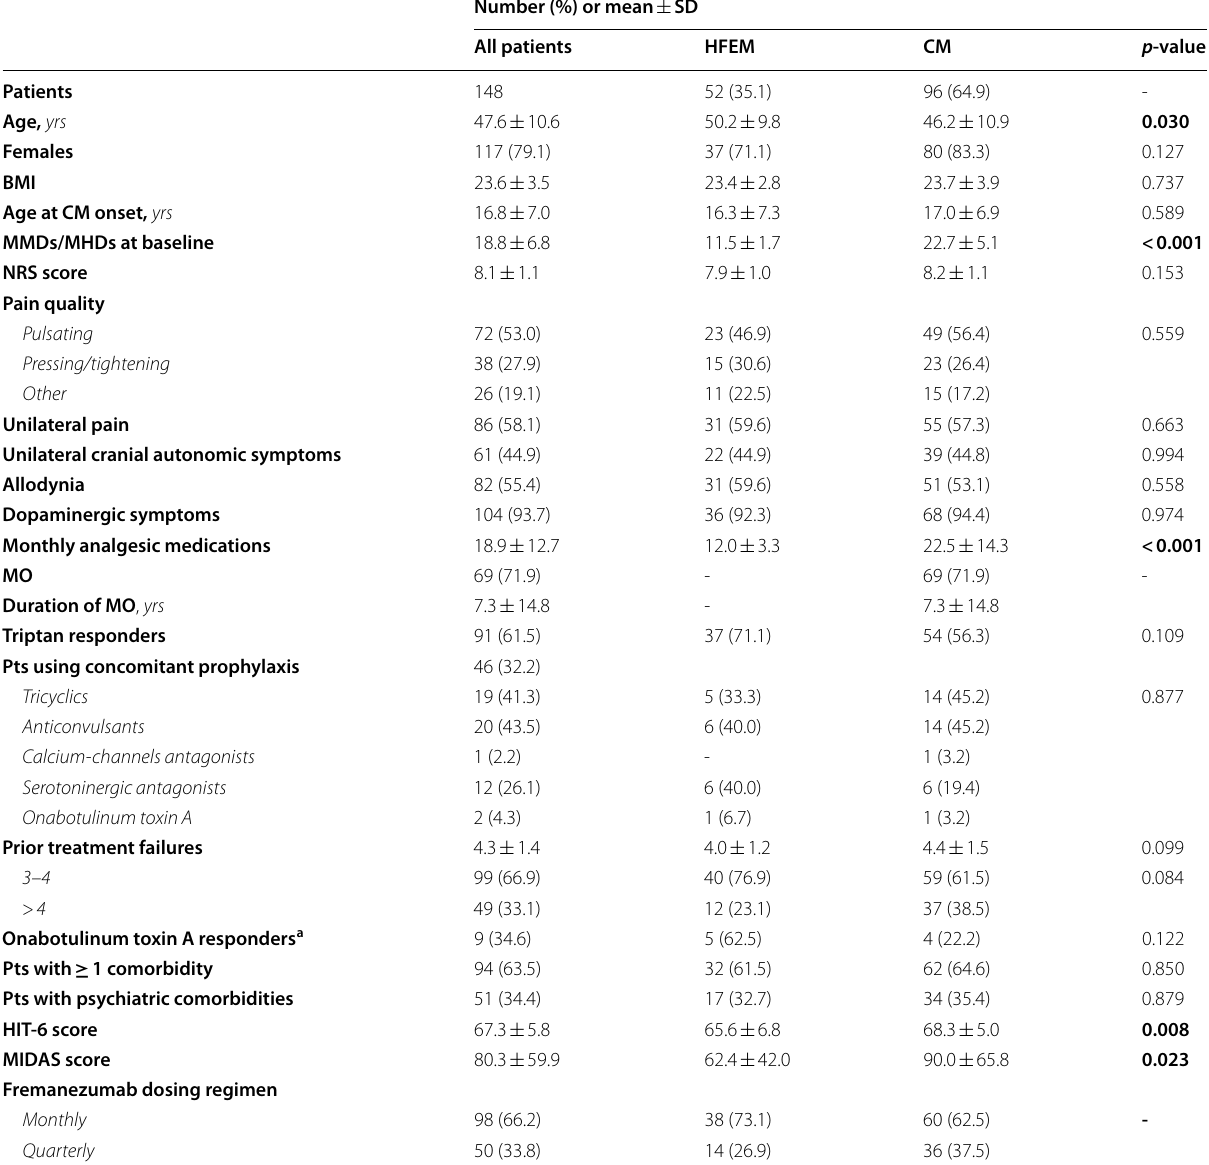
Table 1 Demographic and clinical features of patients with high-frequency episodic migraine (HFEM) or chronic migraine